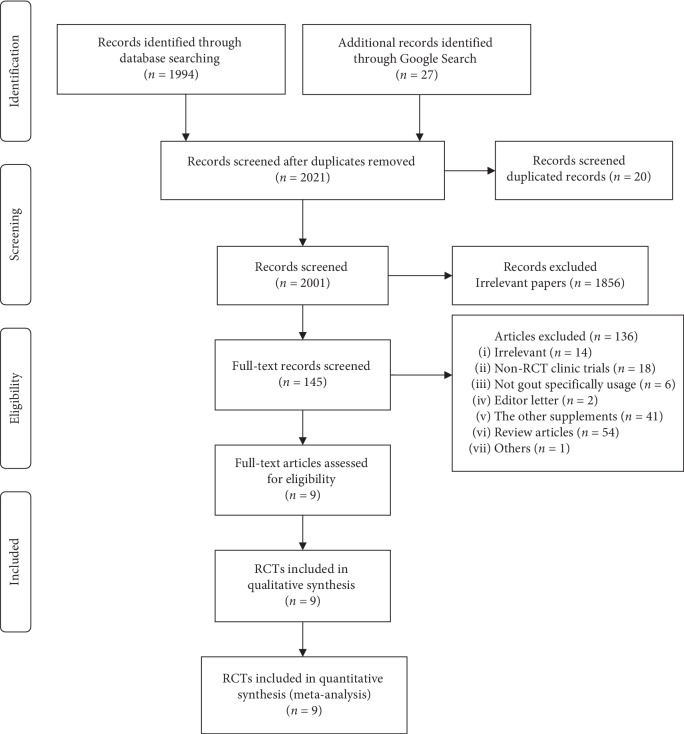
PRISMA flow chart.